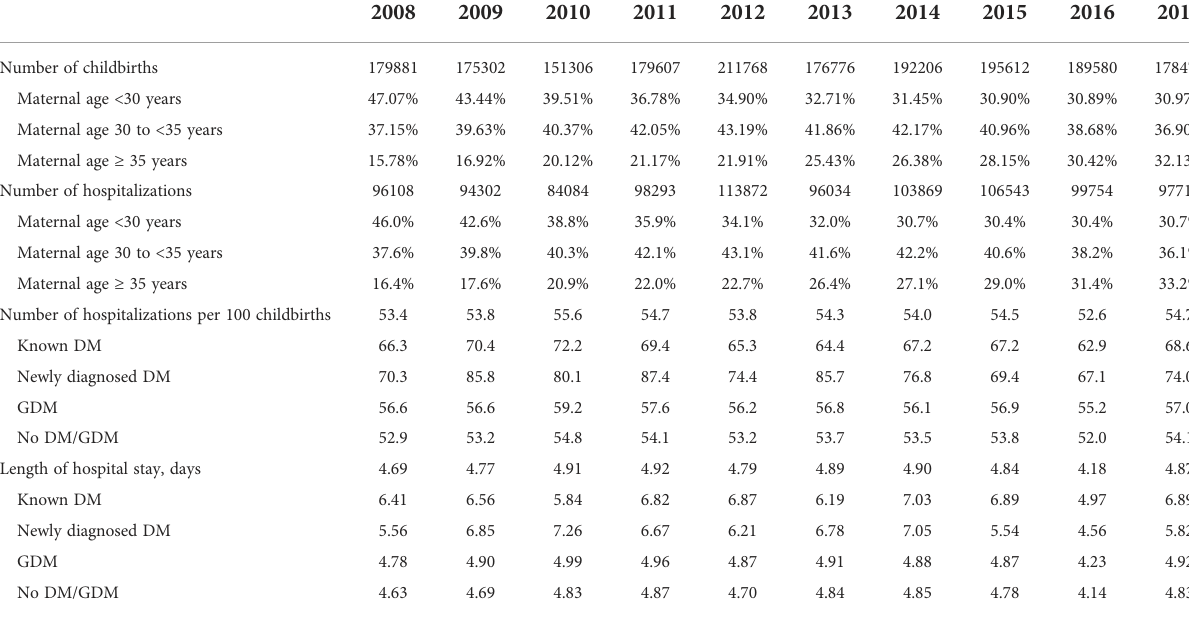
TABLE 1 Number of childbirths, hospitalizations, and length of hospital stay during gestation period from 2008 to